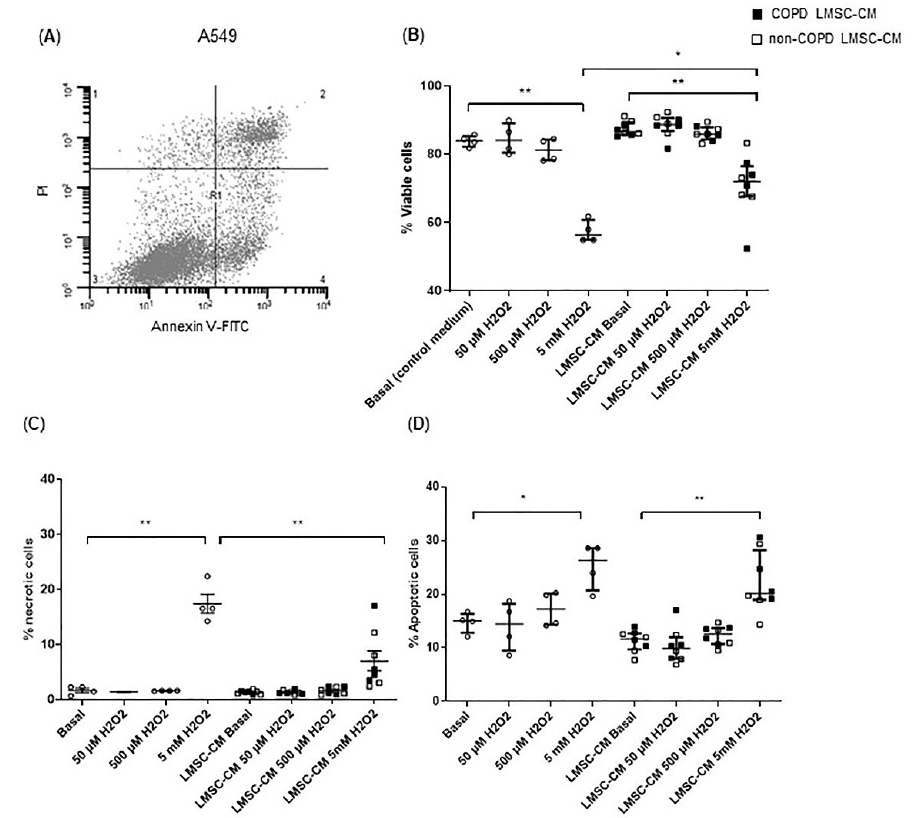
Figure 1. Conditioned medium from lung-resident MSCs (LMSCs) reduces oxidative stress-induced necrotic epithelial cell death. A549 cells were cultured to ~90% confluence and serum-deprived over- night in the presence and absence of conditioned medium (CM) of LMSCs from non-COPD control and COPD donors and treated with 0, 50 µM, 500 µM and 5 mM H 2 O 2 for 4 h. The percentage of viable, early apoptotic, late apoptotic/necroptotic and necrotic cells was determined using annexin- V/propidium iodide (PI) staining using flow cytometry. ( A ) Representative flow cytometry plot rep- resenting the following populations in the respective quadrants: 1. Necrotic cells; 2. Late apop- totic/necroptotic cells; 3. Viable cells; 4. Early apoptotic cells. ( B ) The percentages of viable cells. ( C–D ) The percentages of early apoptotic cells. The percentages of necrotic cells was determined using annexin-V/PI staining for flow cytometry. Medians ± interquartile range (IQR) are shown. To test for differences between control medium and LMSC-condition medium, the Friedman test was used. * = p < 0.05 and ** = p < 0.01 between the indicated values. LMSC-CM from non-COPD donors is indicated by open symbols, from COPD donors by closed symbols. Circles indicate control con- dition without CM. 3.2. Conditioned-Medium from LMSCs Improves Epithelial Repair Migratory and Proliferative Responses upon Injury Next, we assessed the ability of LMSCs to improve epithelial repair upon injury. Elec- tric field-induced cell death resulted in an almost complete detachment of the cells from the electrode, as described previously [22]. This was reflected by a robust decrease in ep- ithelial low-frequency resistance (Figure 2A,C) and concomitant increase in high-fre- quency capacitance levels, from which the cells recovered within 0–6 h upon wounding (Figure 2B,C), repopulating the denuded area. After 6 h, the resistance gradually increased further (Figure 2A,C), reflecting the re-establishment of intercellular contacts [22]. LMSC-